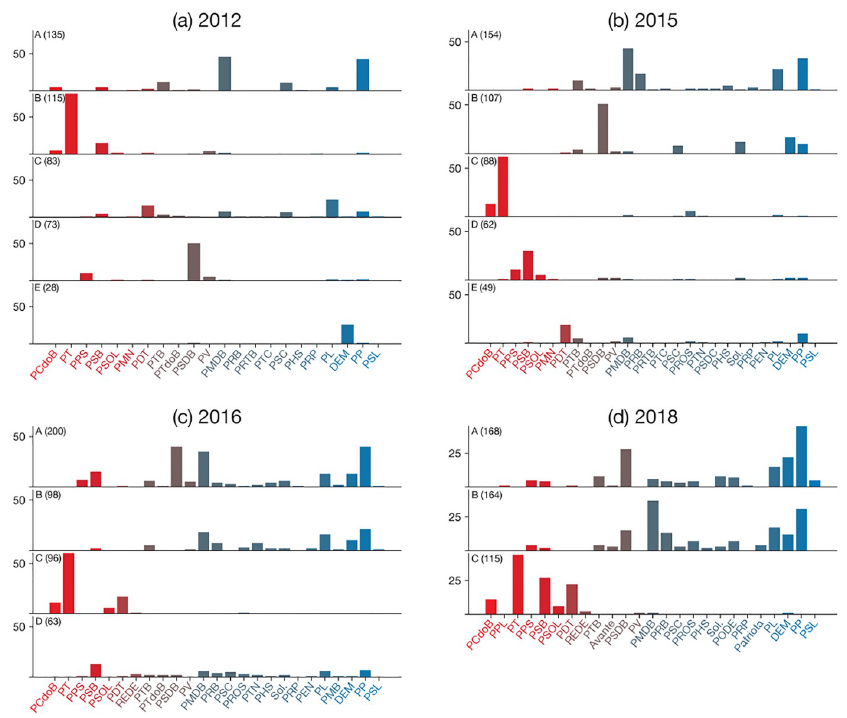
Fig 13. Distribution of parties among communities before and after the impeachment of Dilma Rousseff. The charts are organized in a similar fashion as those shown in Fig